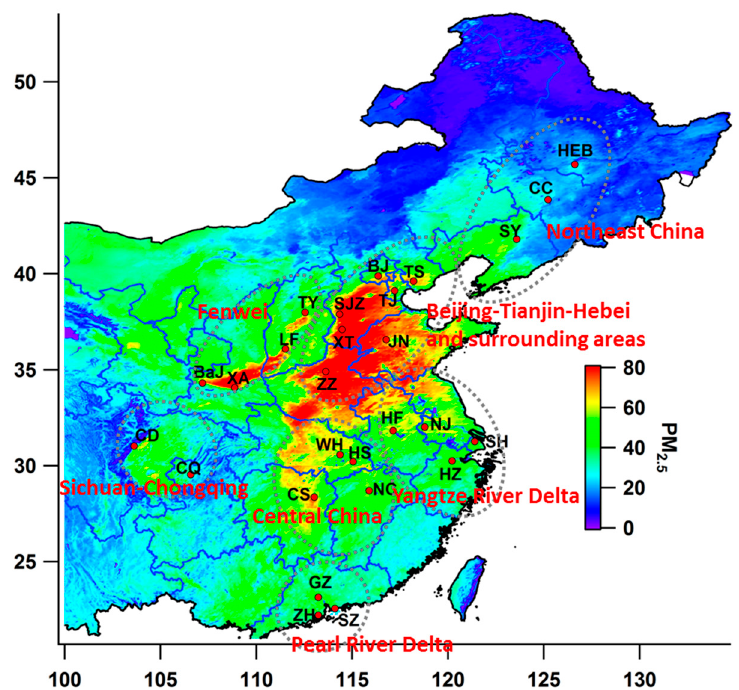
Figure 1. Average PM 2.5 mass concentration distribution during the autumn and winter of 2013–2020 in the central and eastern of China. The circle is the approximate position of the region.